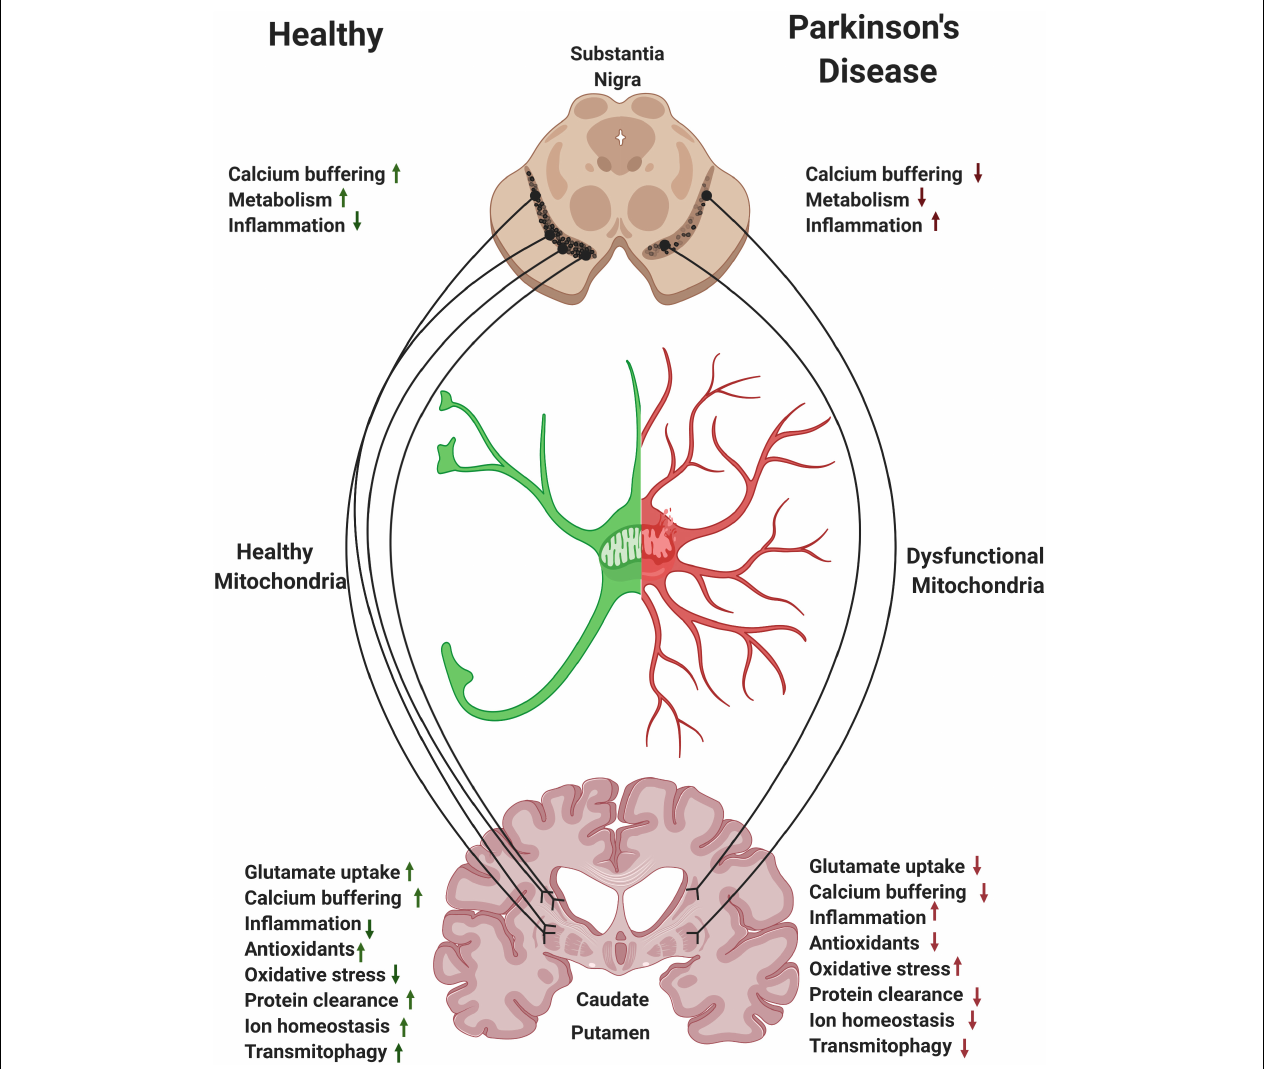
FIGURE 3 | Astrocytes and the nigrostriatal pathway. Within the nigrostriatal pathway, astrocyte numbers and functions are most abundant in the striatum/caudate putamen, where dopaminergic neurons support is the highest and where loss of astrocytic function is likely to have the most detrimental effect in Parkinson’s disease (PD). Reversing mitochondrial dysfunction in astrocytes in the striatum may induce significant therapeutic benefit in